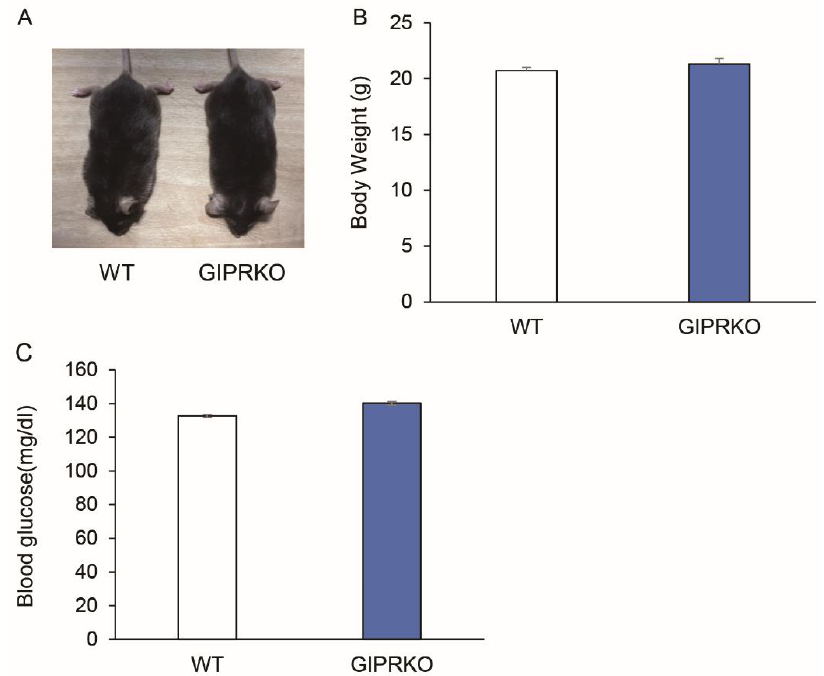
Figure 1. Body weights and blood glucose levels of WT and GIPRKO. ( A ) Photos of mice from the WT and the GIPRKO. ( B ) Body weights ( n = 5) and ( C ) blood glucose levels ( n = 5) were represented. Results are expressed as mean ± SEM.